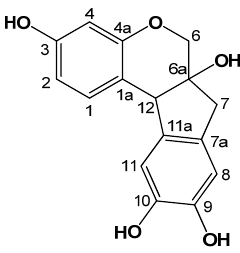
Figure 1. Chemical structure of compound 1